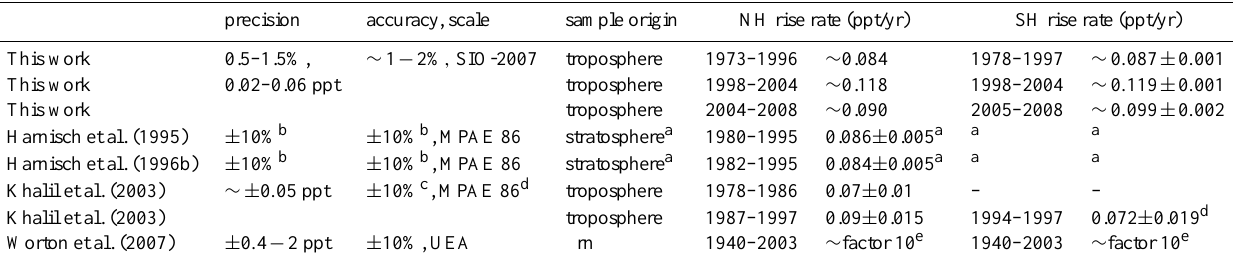
Table 4. C 2 F 6 measurement precisions, scale accuracies, sample origins, and tropospheric trends.